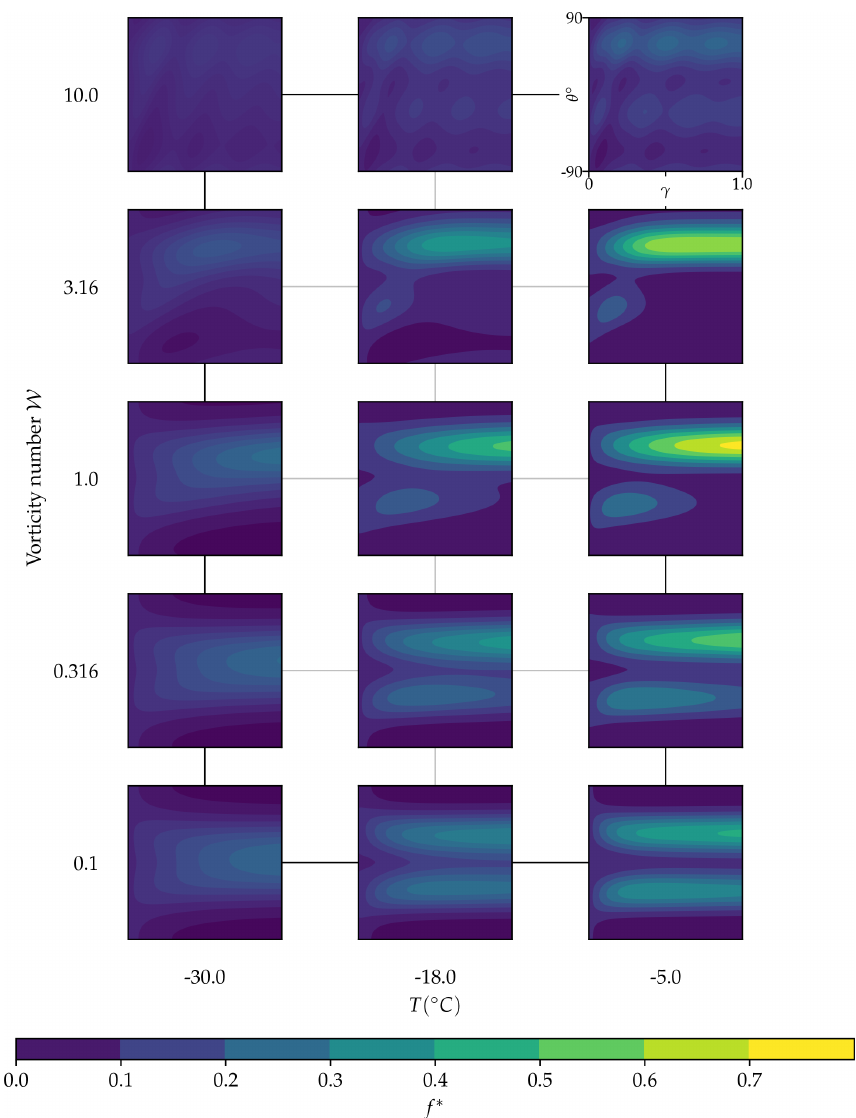
Figure 8. Slices of the pole figure showing the value of the orientation distribution function f ∗ at y = 0 for an array of temperatures and vorticity numbers. All plots go to a strain of γ = 1. The colour limits are the same for all